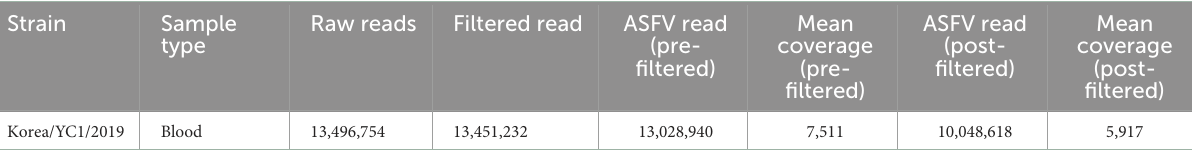
TABLE 1 Summary of the Korea/YC1/2019 strain genomic sequencing